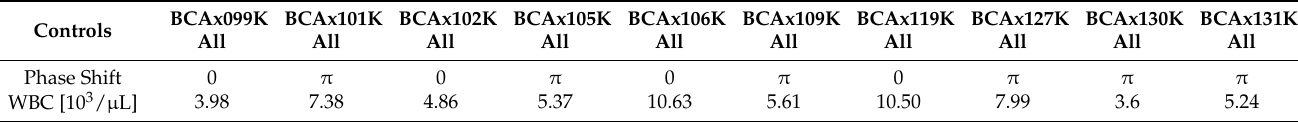
Table 4. Correlations between phase shift and WBC level for the control